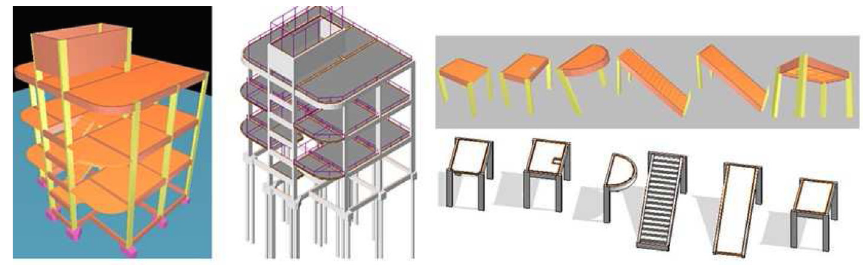
Fig. 7. Examples of models generated in Software A and Software